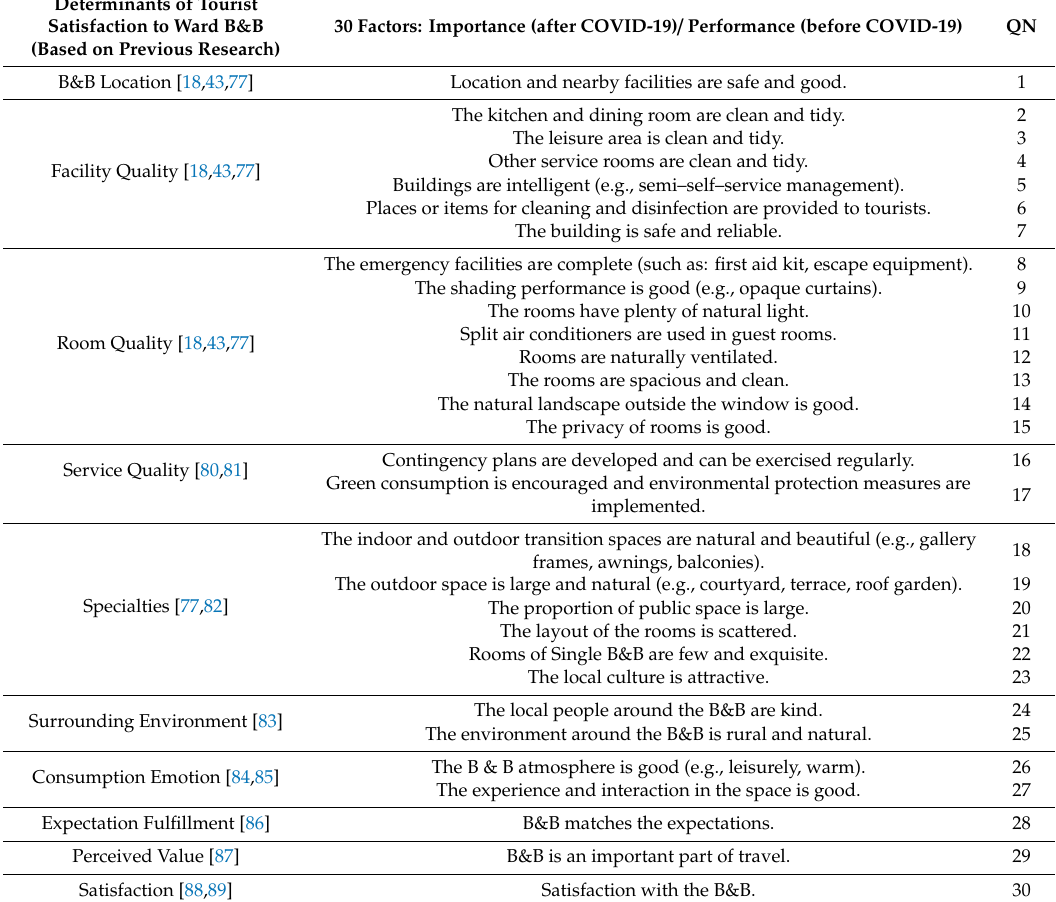
Table 1. The 30 items to measure B&B experience before / after